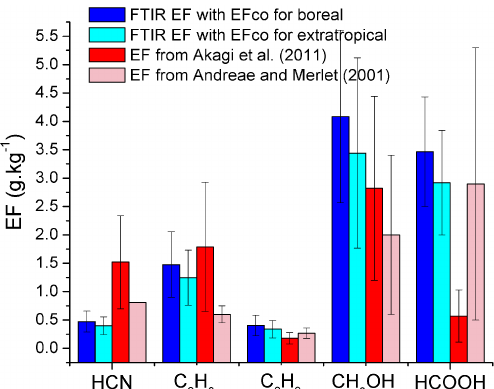
Figure 10. Emission factors for boreal and extratropical EF CO calculated from FTIR measurements (blue and cyan), along with the emission factors found in the compilation studies of Akagi et al. (2011) (red) and Andreae and Merlet (2001)